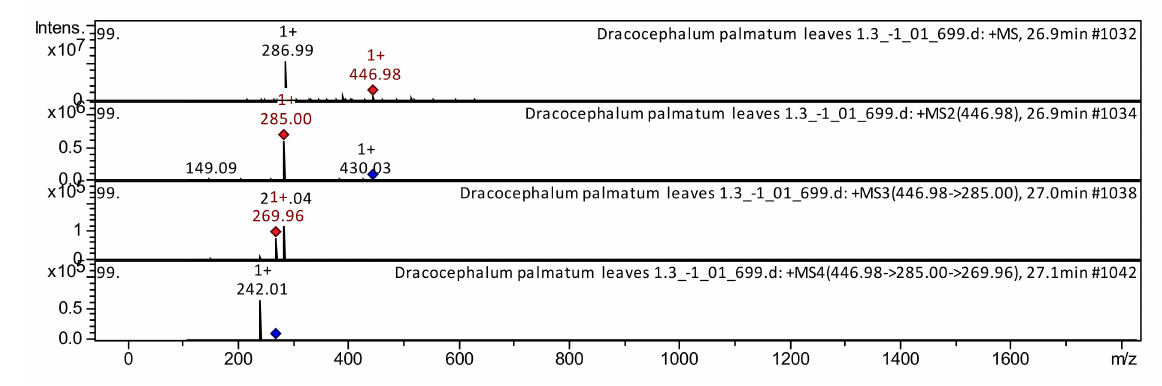
Figure 6. CID spectrum of acacetin 7- O -glucoside from D. palmatum , m / z 446.98. The [M + H] + ion produced three fragment ions at m / z 285, m / z 430, and m / z 149 (Figure 6). The fragment ion with m / z 285 yields a daughter ion at m / z 269. The